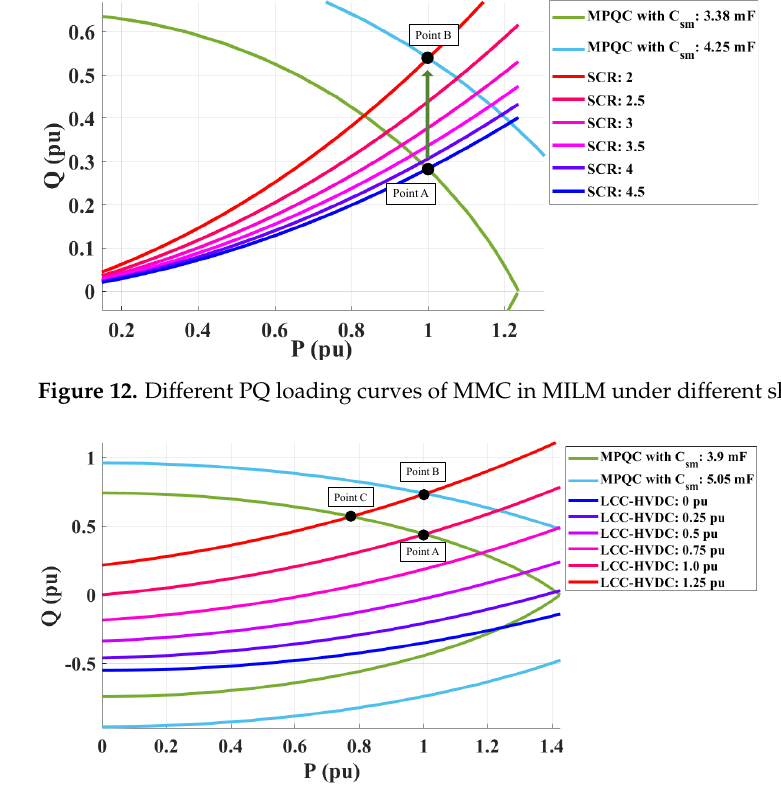
Figure 13. Different PQ loading curves of MMC in MILM case under different LCC-HVDC operat- ing